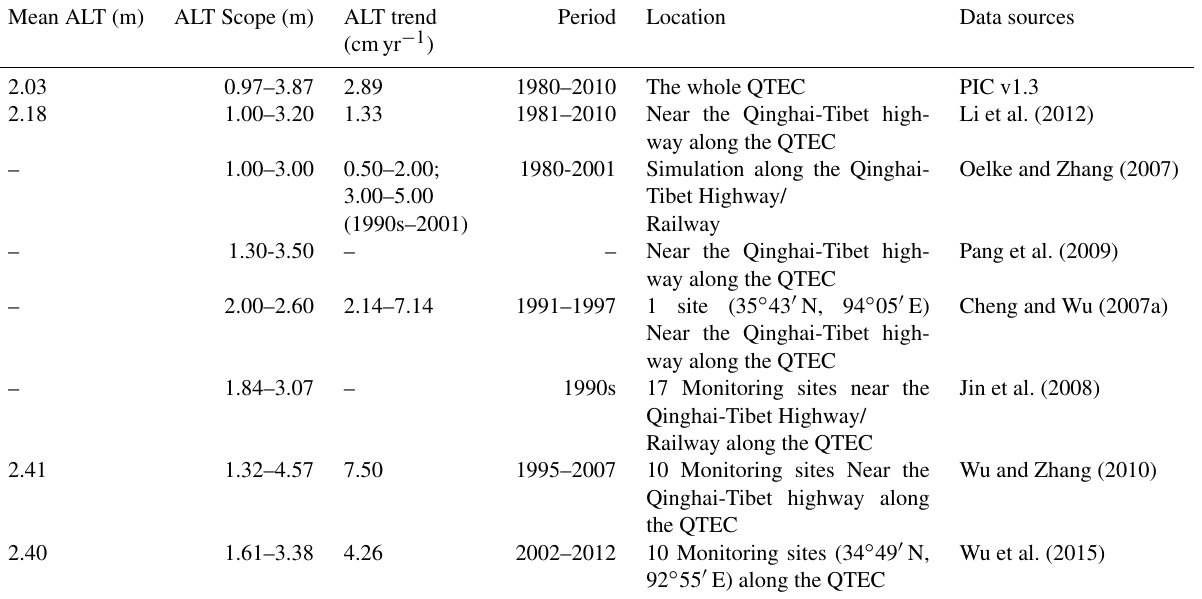
Table 5. The active layer thickness (ALT) and its trend between the PIC v1.3 simulation and literature analysis in the Qinghai-Tibet Engi- neering Corridor